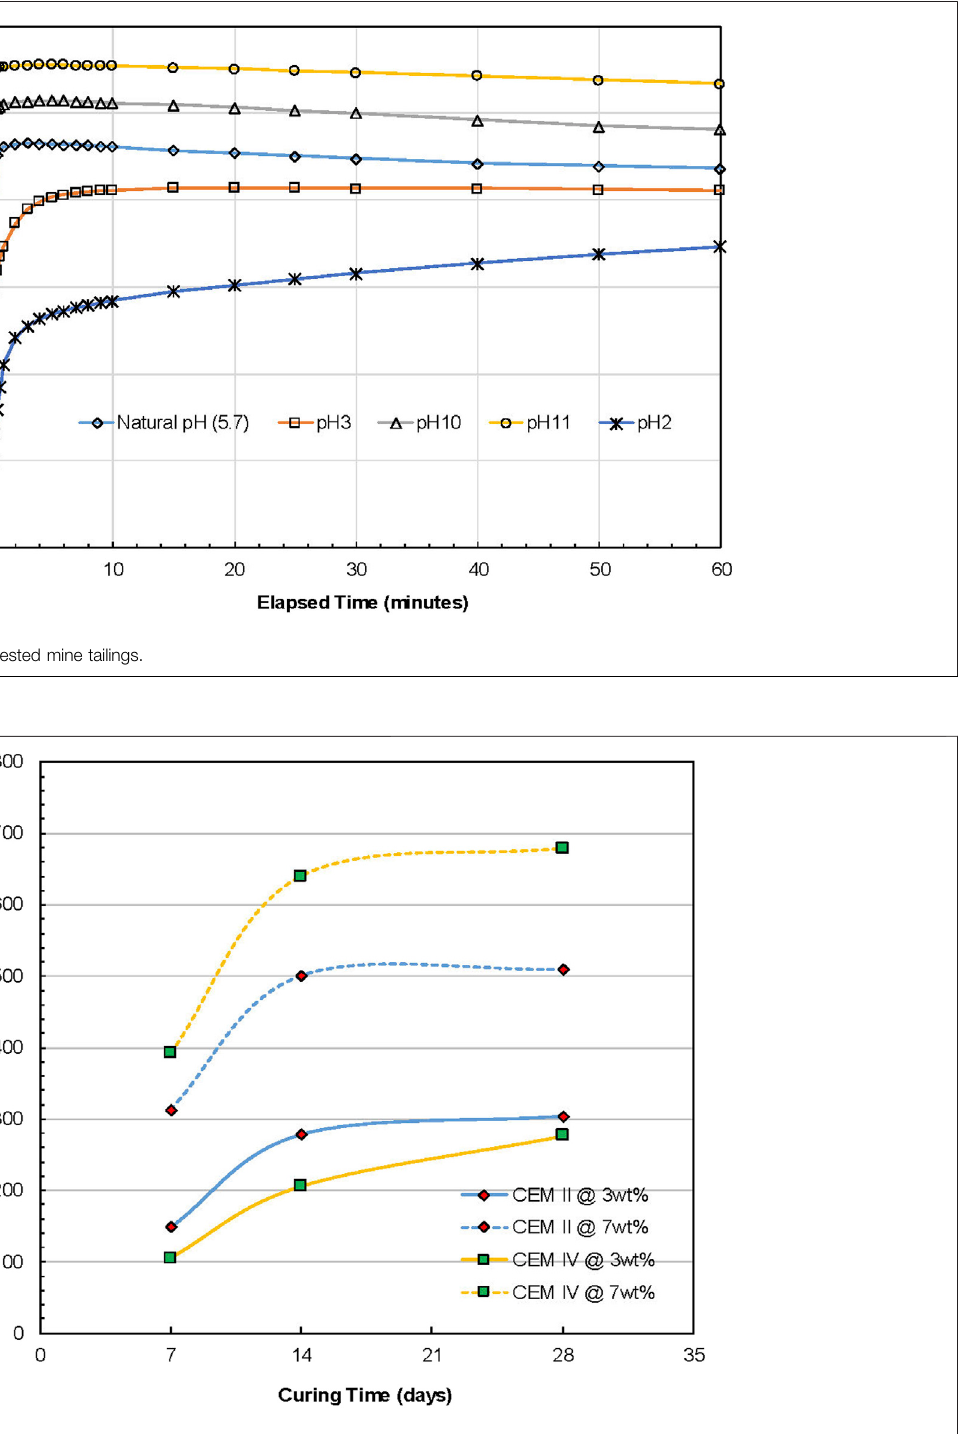
FIGURE 4 | UCS test results of different CPB samples as a function of curing